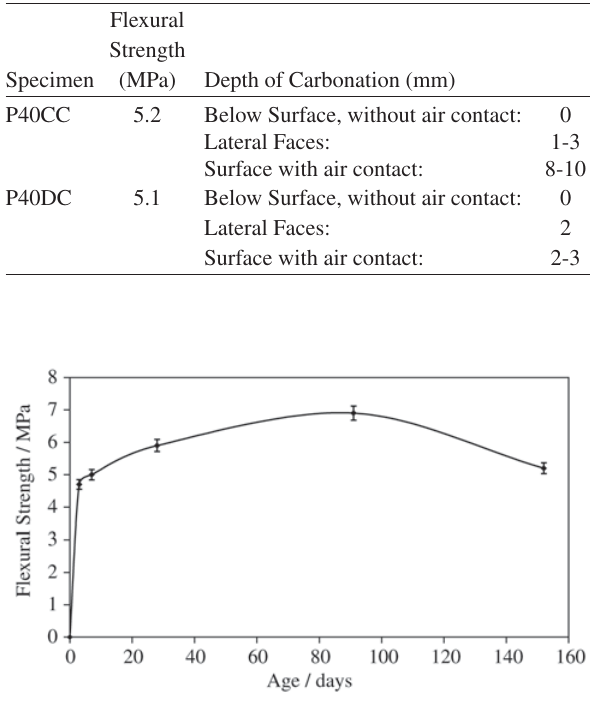
Figure 1. Flexural Strength of C40 Concrete.